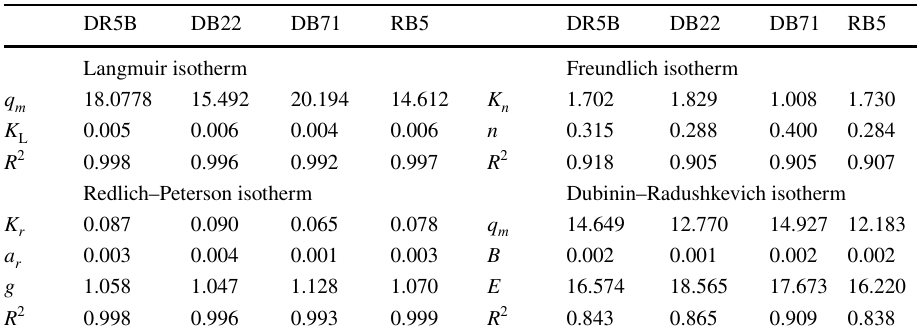
Table 2 Comparison of SMW’s adsorption capacity for anionic dyes with the values of other adsorbents